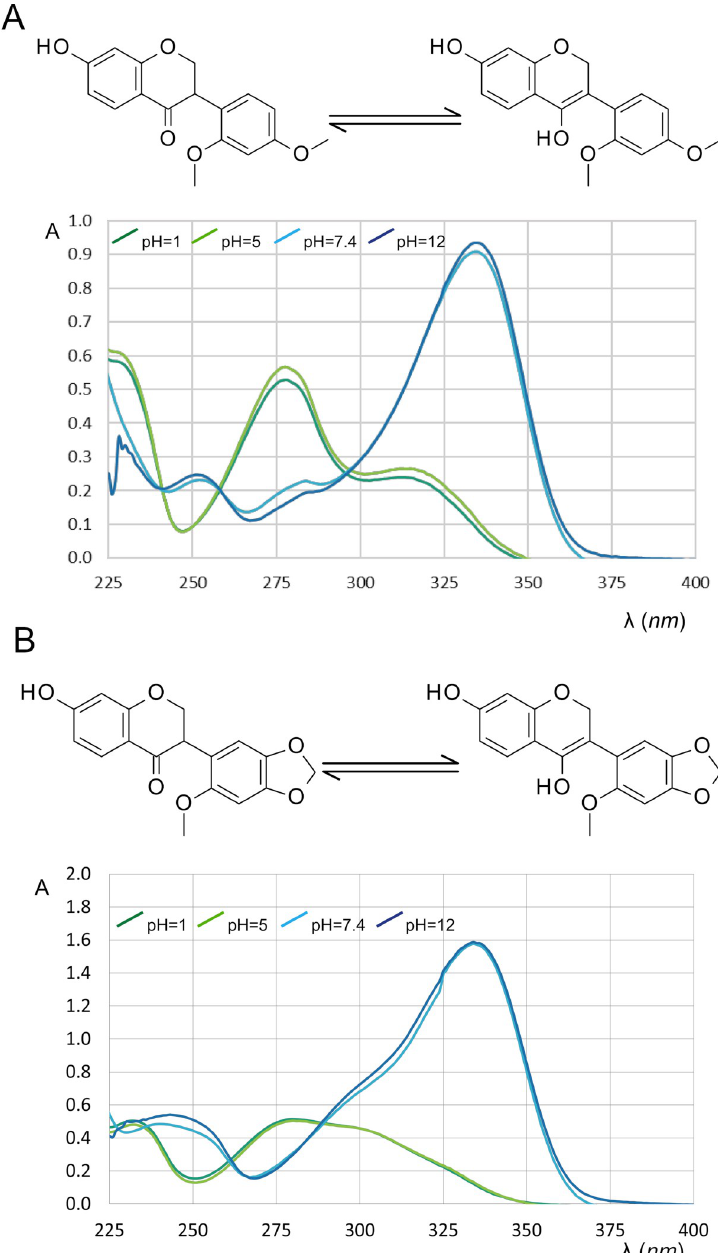
Fig 2. The oxo-enol tautomerism and pH dependent UV spectra of sativanone (A) and onogenin (B). molecules as BBB+ above a log BB -0.5 value and defined the arbitrary unit of -6.0 of log P an effective discriminator between BBB+ and BBB- structures. Di et al . determined an uncer- tain, intermediate zone between P -5.39) [31, 32]. After analyzing the experimental log P can be observed. The isoflavones calycosin D and formononetin had the lowest log P followed by isoflavanones sativanone and onogenin, while the highest values were measured